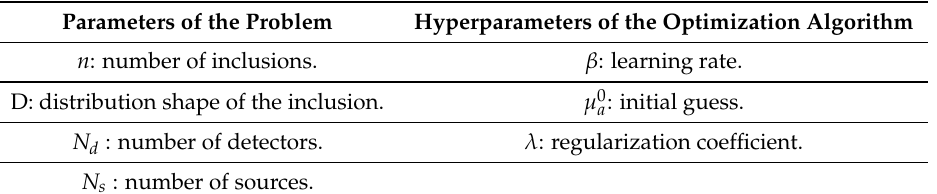
Table 1. Parameters and hyperparameters of interest. Parameters of the Problem Hyperparameters of the Optimization